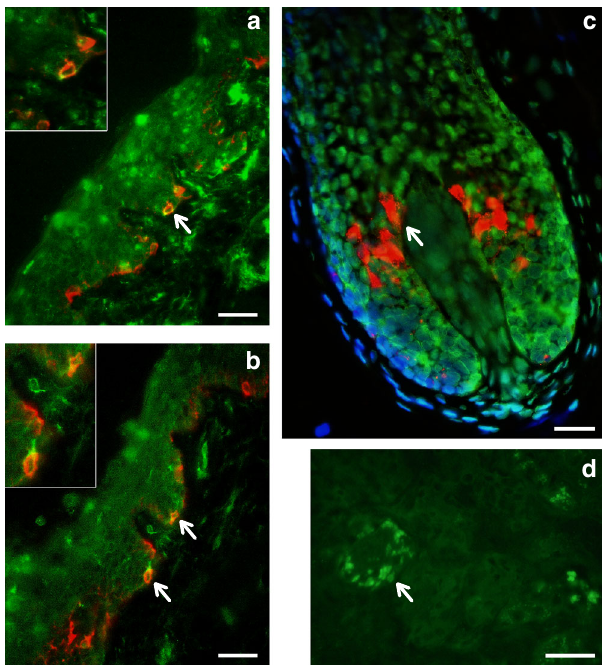
Fig. 7 Immunohistochemical analysis of MFSD12 protein expression in the epidermis of human scalp. MFSD12 expression (green fl uorescence) was detected in multiple skin cell types ( a , b ). MFSD12 expression levels were higher in melanocytes (identi fi ed with an anti-melanocyte antibody in red fl uorescence) than in adjacent keratinocytes (green only). Co-localization of both MFSD12 and the melanocyte-speci fi c protein gp100 expression can be seen in yellow/orange fl uorescence (arrow). Insets show higher magni fi cation views of arrowed MFSD12 -expressing melanocytes in skin epidermis. c A proportion of keratinocytes in scalp hair follicle from the same tissue also expressed MFSD12 (green only). By contrast with the skin, MFSD12 expression was not detected in hair melanocytes (i.e., seen as red fl uorescence only indicating gp100 protein expression). d Positive control (human kidney). Note MFSD12 expression in kidney tubular